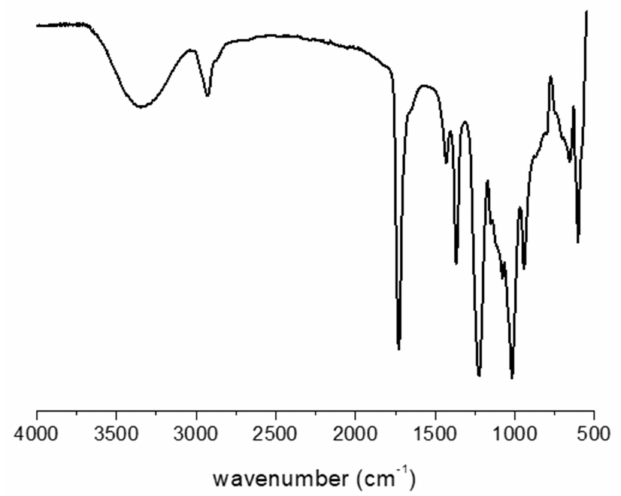
Figure 3. FT-IR spectrum of the poly(ethylene- co -vinyl acetate), produced via CD-assisted aqueous free radical polymerization.